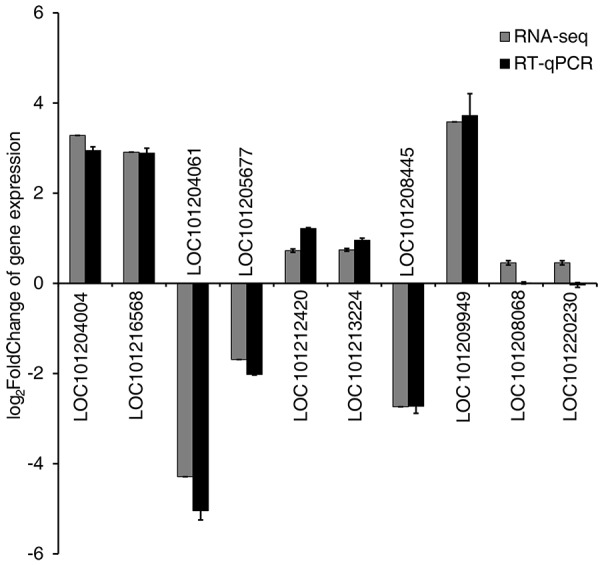
Validation of RNA-seq results by quantitative real-time PCR (RT-qPCR). Expression patterns of 10 representative genes as determined by RT-qPCR and RNA-seq. Normalization for RT-qPCR was performed using expression of the EF1α gene as an internal reference. Error bars on the black boxes indicate the standard deviations of three biological replicates of RT-qPCR analysis. The bars on the gray boxes indicate the false discovery rates from the two biological replicates of RNA-seq analysis.